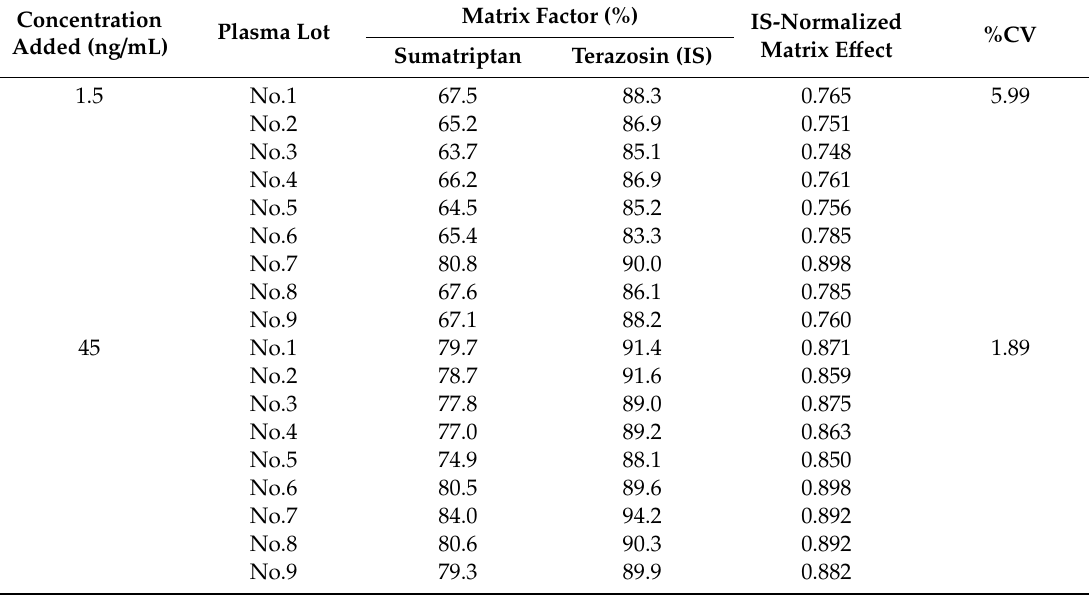
Table 3. Matrix e ff ect of sumatriptan in nine lots of human plasma ( n = 3).